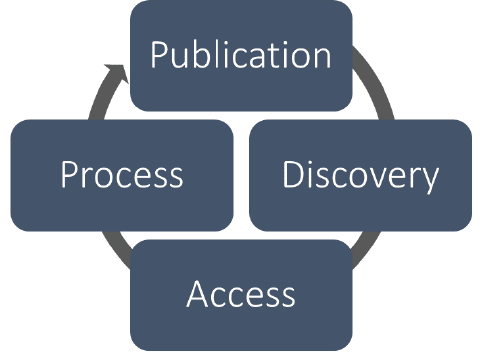
Figure 1. Content life cycle in Spatial Data Infrastructures